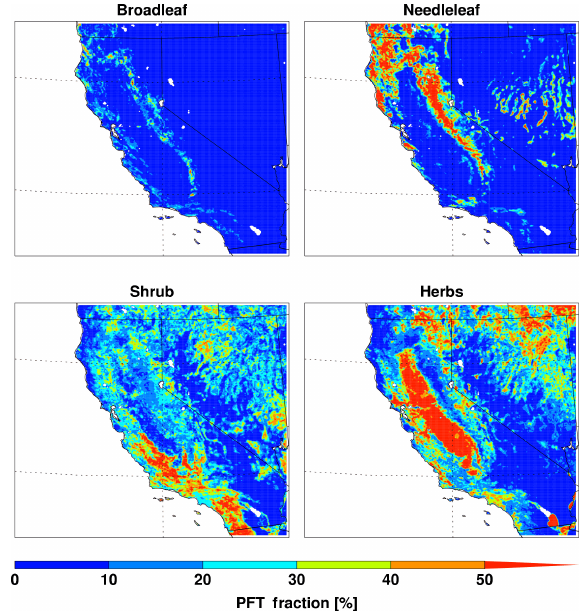
Figure 2. Spatial distribution of dominant PFTs over the simulation domain from the four data sets: USGS, VEG1, VEG2, and VEG3. The PFT number refers to the list in Table 1.